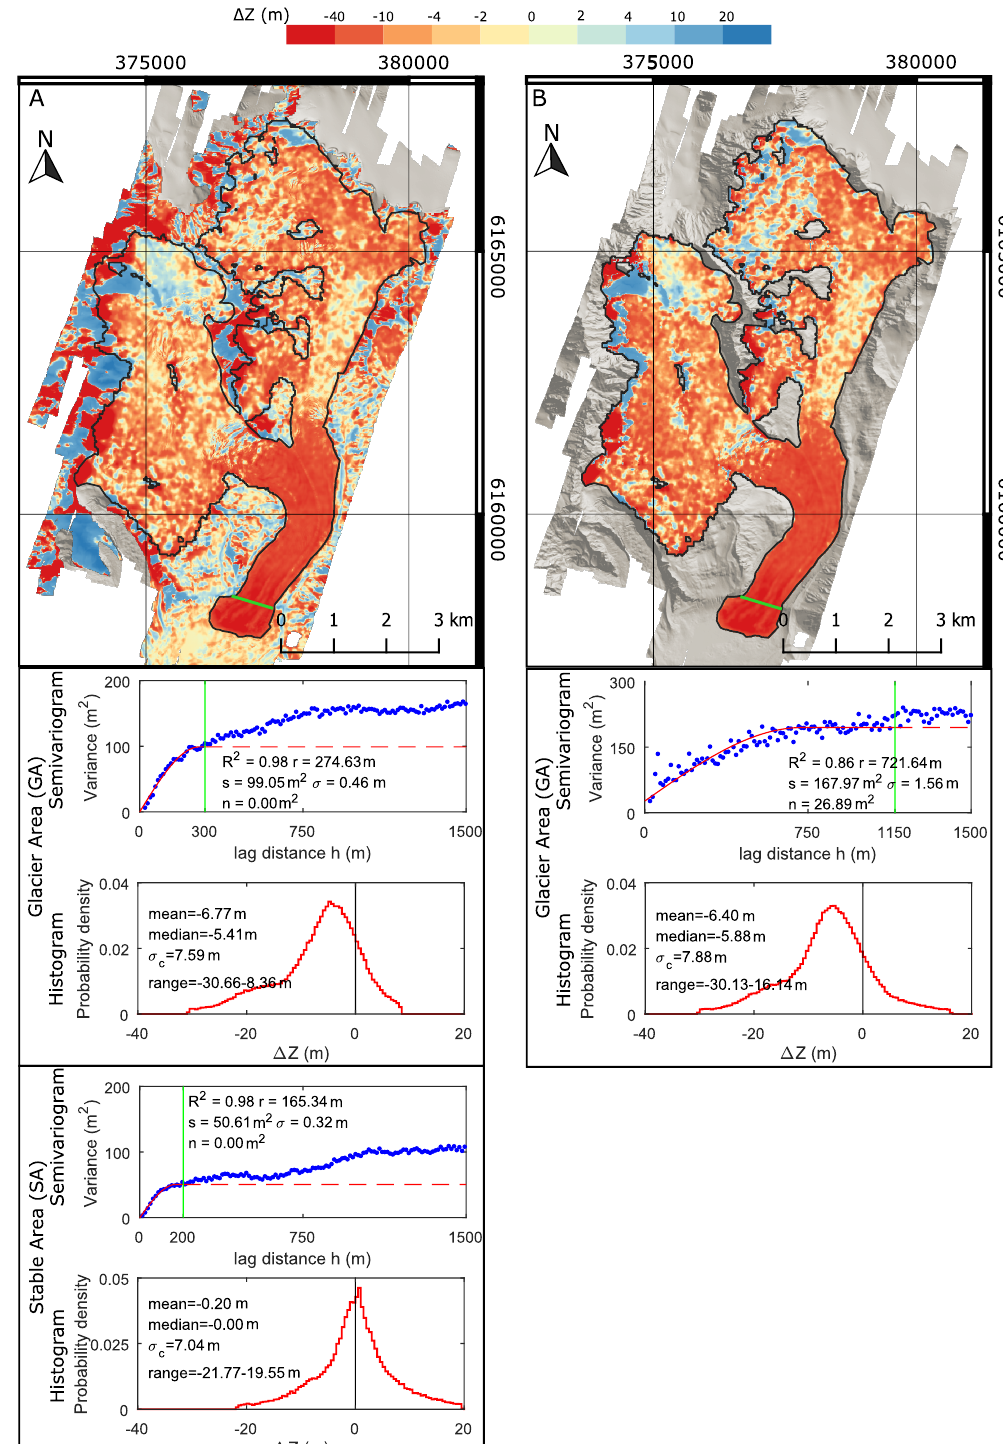
Figure 6. Results of DEM subtraction with semivariograms and histograms of differences. ( A ): ALS- SRTM; ( B ): TanDEM-SRTM. Resolution of both maps is 12 m. Blue dots represent empirical semivariograms, while red lines—synthetic ones. Green vertical line indicates distance threshold of the best fit of the model to the data. Black line on the map delimits the GA, green line corresponds to transect line used for creation of Figure